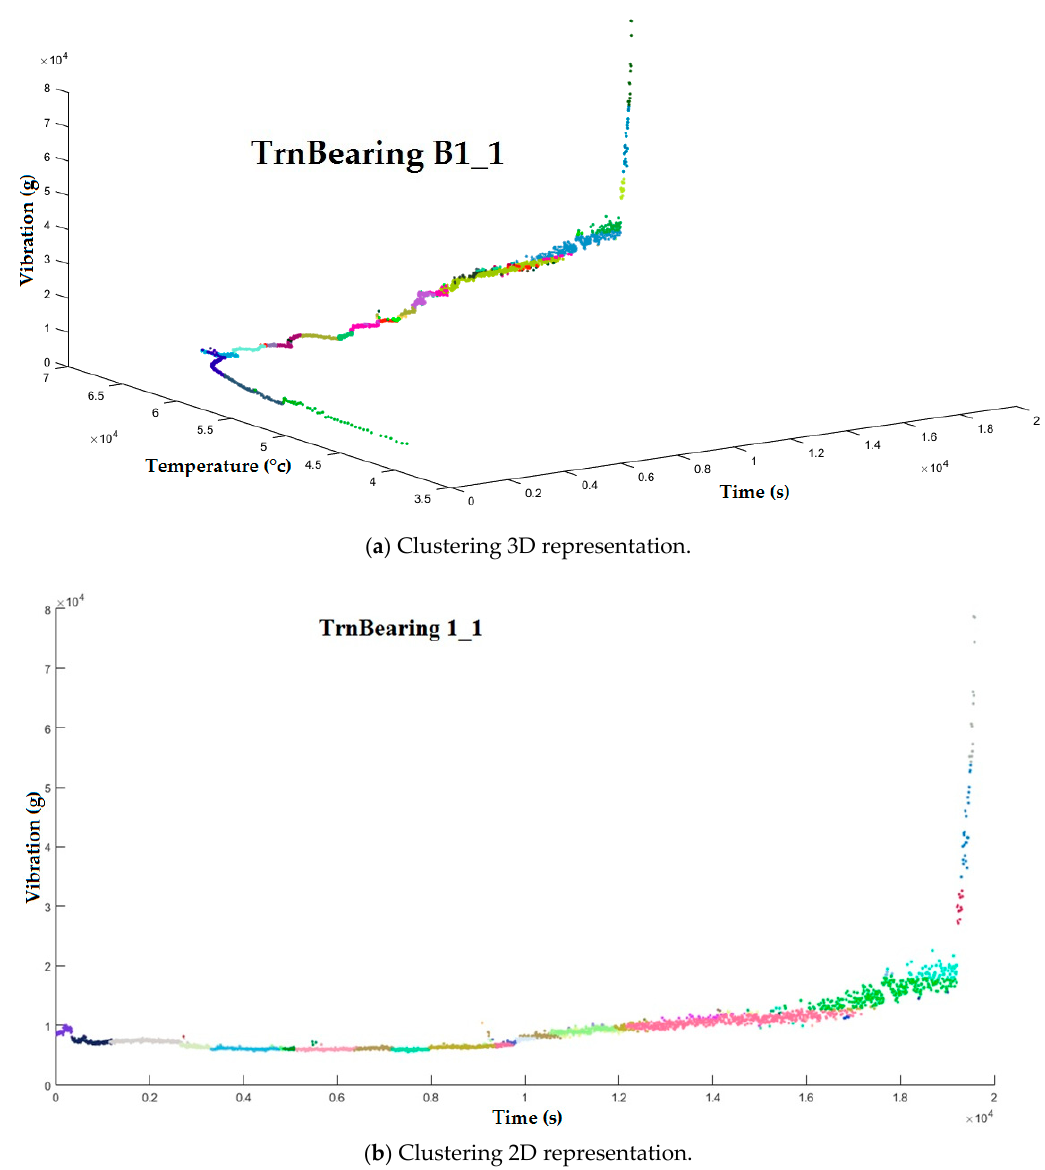
Figure 14. Random initial solution generation result for PRONOSTIA dataset B1_1.